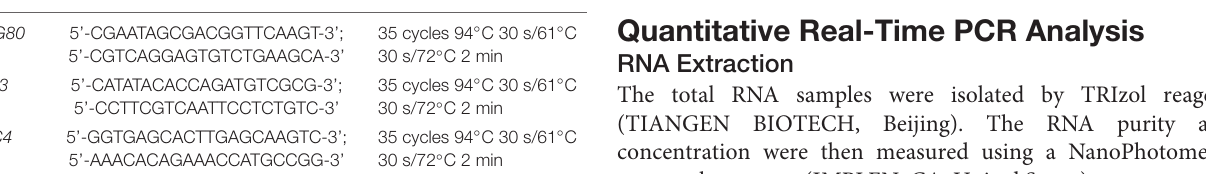
TABLE 1 | List of PCR primer pairs designed and used for this study. Primers